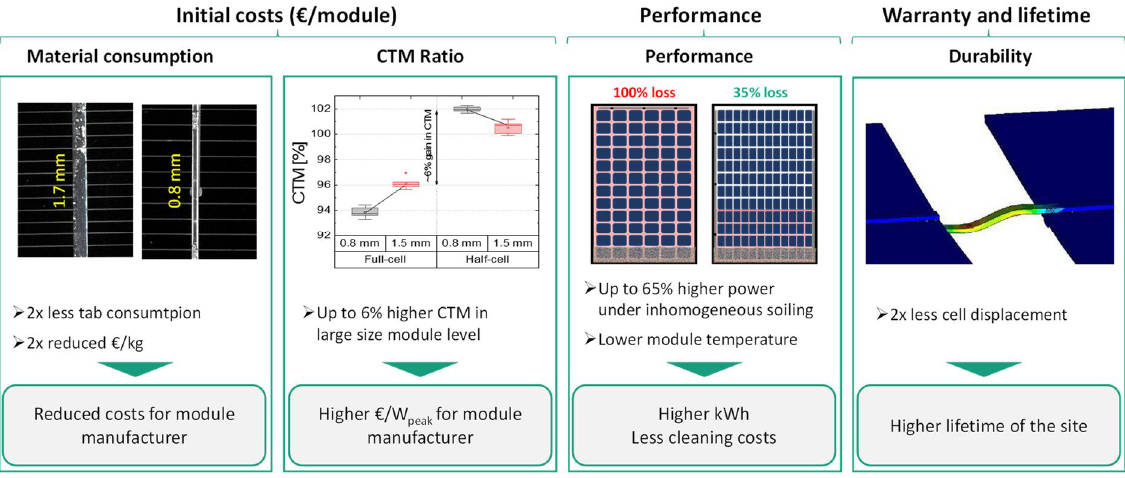
Figure 18. Techno-economical advantages of half-cell modules for initial costs, performance and soiling issues and cell displacement. These advantages indicate a lower LCOE for half-cell modules in desert